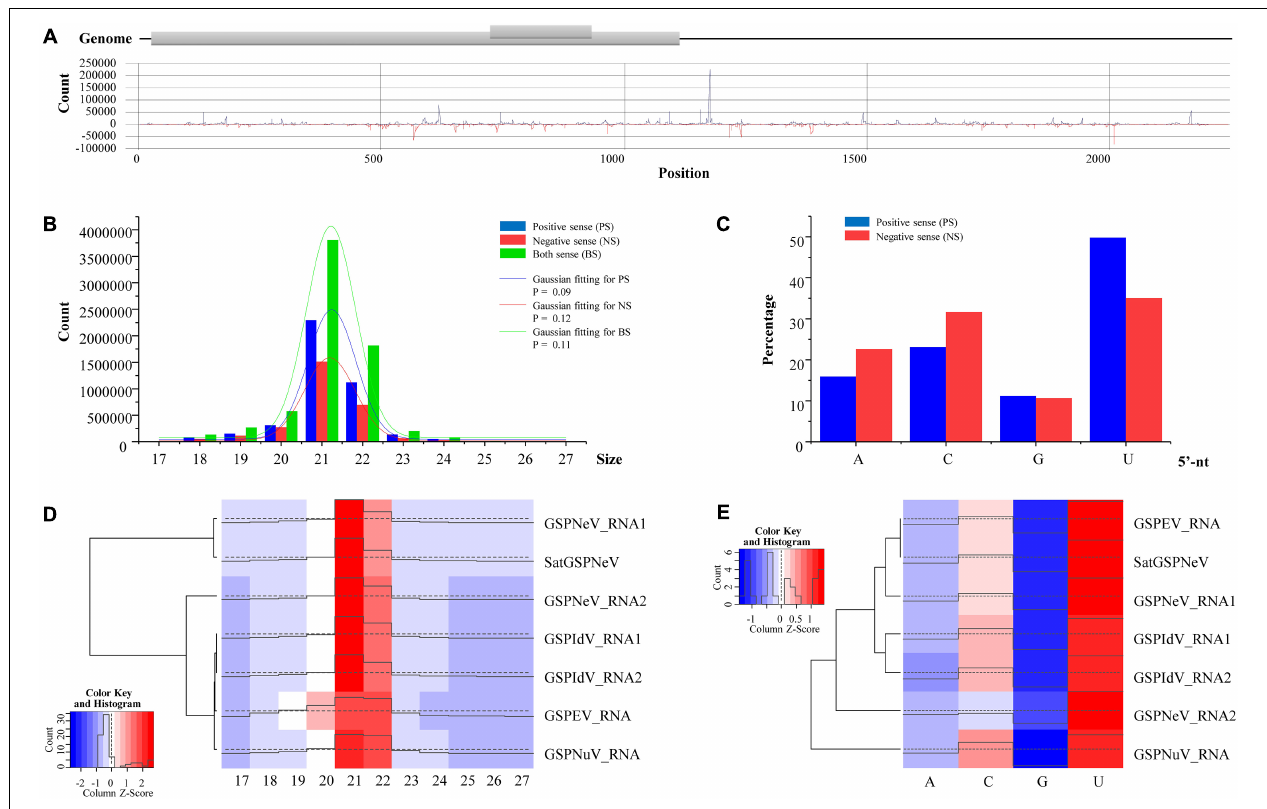
FIGURE 5 | Small RNA (sRNA) analysis of green Sichuan pepper-nepovirus large linear satellite RNA (satGSPNeV). Distribution of sRNAs derived from positive and negative strands of satGSPNeV in its sequences (A) . The size distribution of satGSPNeV-derived sRNAs in positive, negative, or both strands is in line with the normal distribution (B) . The 5 (cid:48) -nucleotide bias of satGSPNeV sRNAs (C) . Small RNA size distribution (D) and 5 (cid:48) -nucleotide bias (E) patterns of satGSPNeV are similar to those of other coinfecting RNA viruses; the color and histogram annotations are associated with abundance of specific sRNAs, with higher the histogram and deeper the red (or lighter the blue) representing higher the numbers of